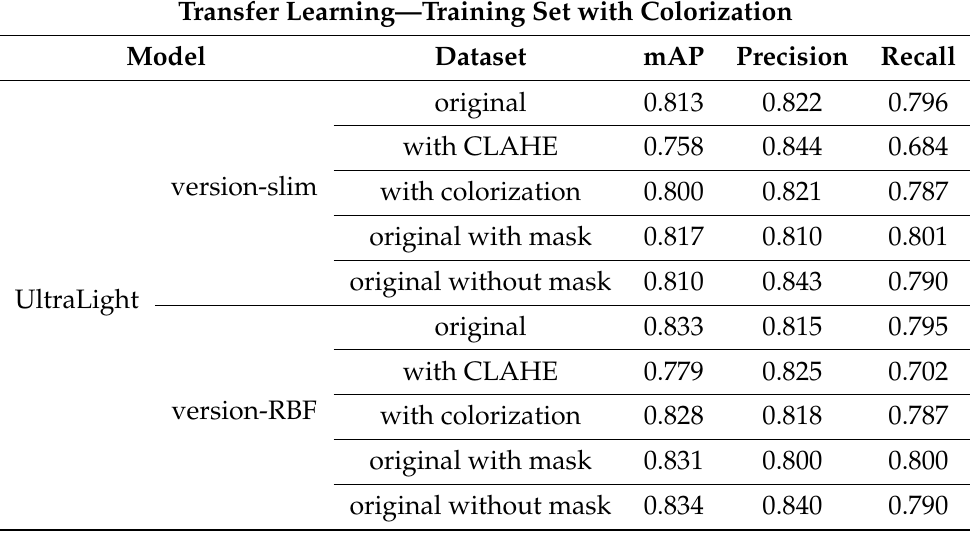
Table 6. Results obtained for testing model trained on own dataset with colorization. Transfer Learning—Training Set with